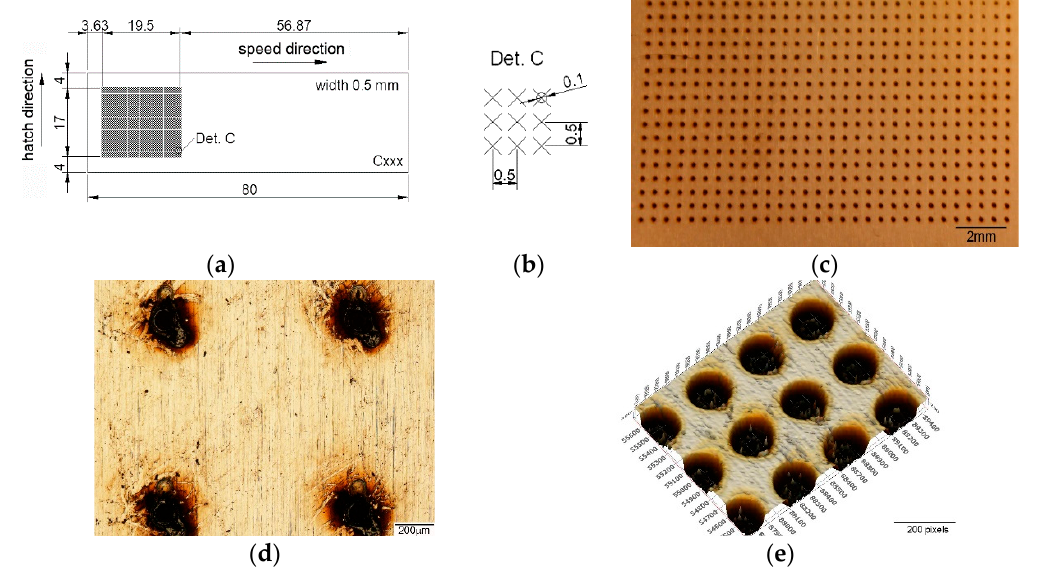
Figure 4. ( a ) Schematic representation of the test sample and pattern design type C, ( b ) detail of the pattern design C (all dimensions in mm), ( c , d ) macro and microscopic image, ( e ) 3D topographic image of LST design type C adapted from [39].